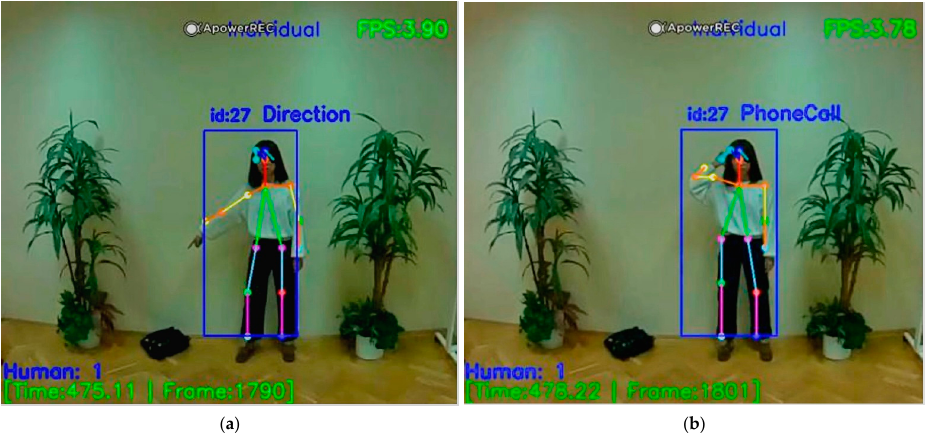
Figure 12. Direction gesture recognition ( a ) and PhoneCall gesture recognition ( b ).